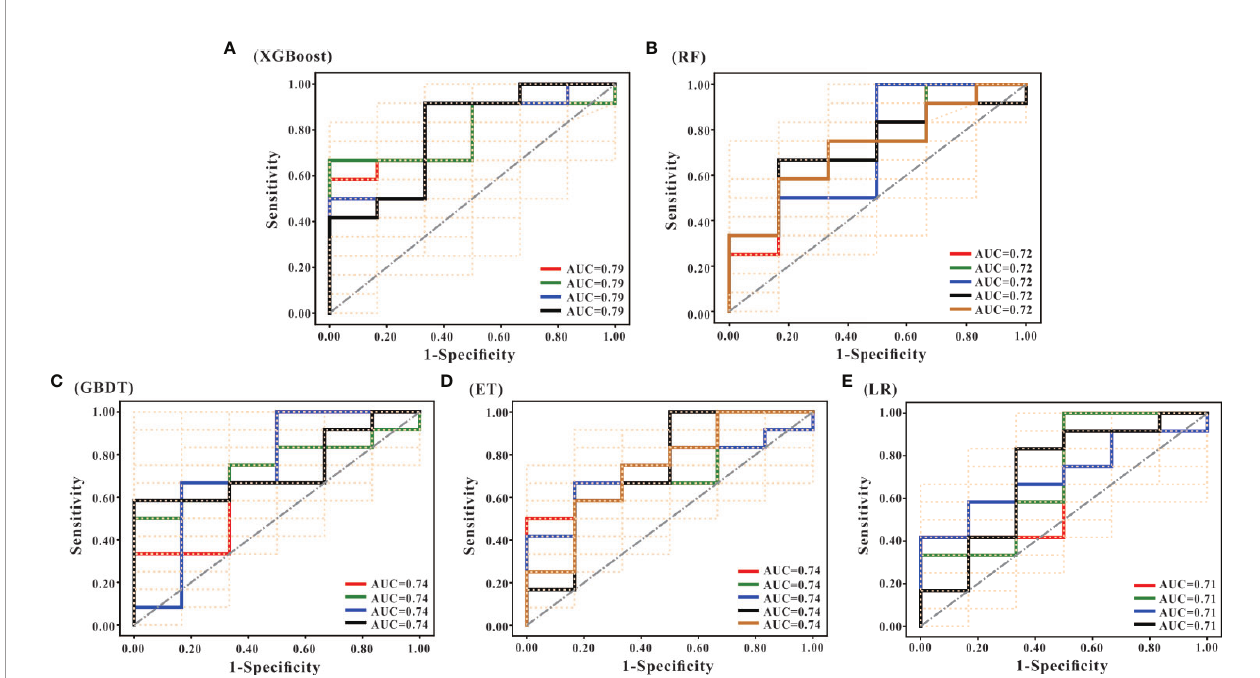
FIGURE 4 | ROC curves of the models. (A – E) are the ROC curves of the models generated by the XGBoost, RF, GBDT, ET, and LR algorithms based on the optimal feature subset, respectively. Each algorithm generated models using 50 different training sets. Therefore, each algorithm has 50 ROC curves. As shown in (A) , the mode of AUC is 0.79 together with 4 ROCs; the mode of AUC in (B) is 0.72, and there are 5 ROCs; the mode of AUC in (C) is 0.74, and there are 4 ROCs; the mode of AUC in D is 0.74, with a total of 5 ROCs; and the mode of AUC in € is 0.71, with a total of 4 ROCs. According to the combination of the 50 ROC distributions and AUC values, the XGBoost model has the best prediction performance, and the LR model has the worst prediction